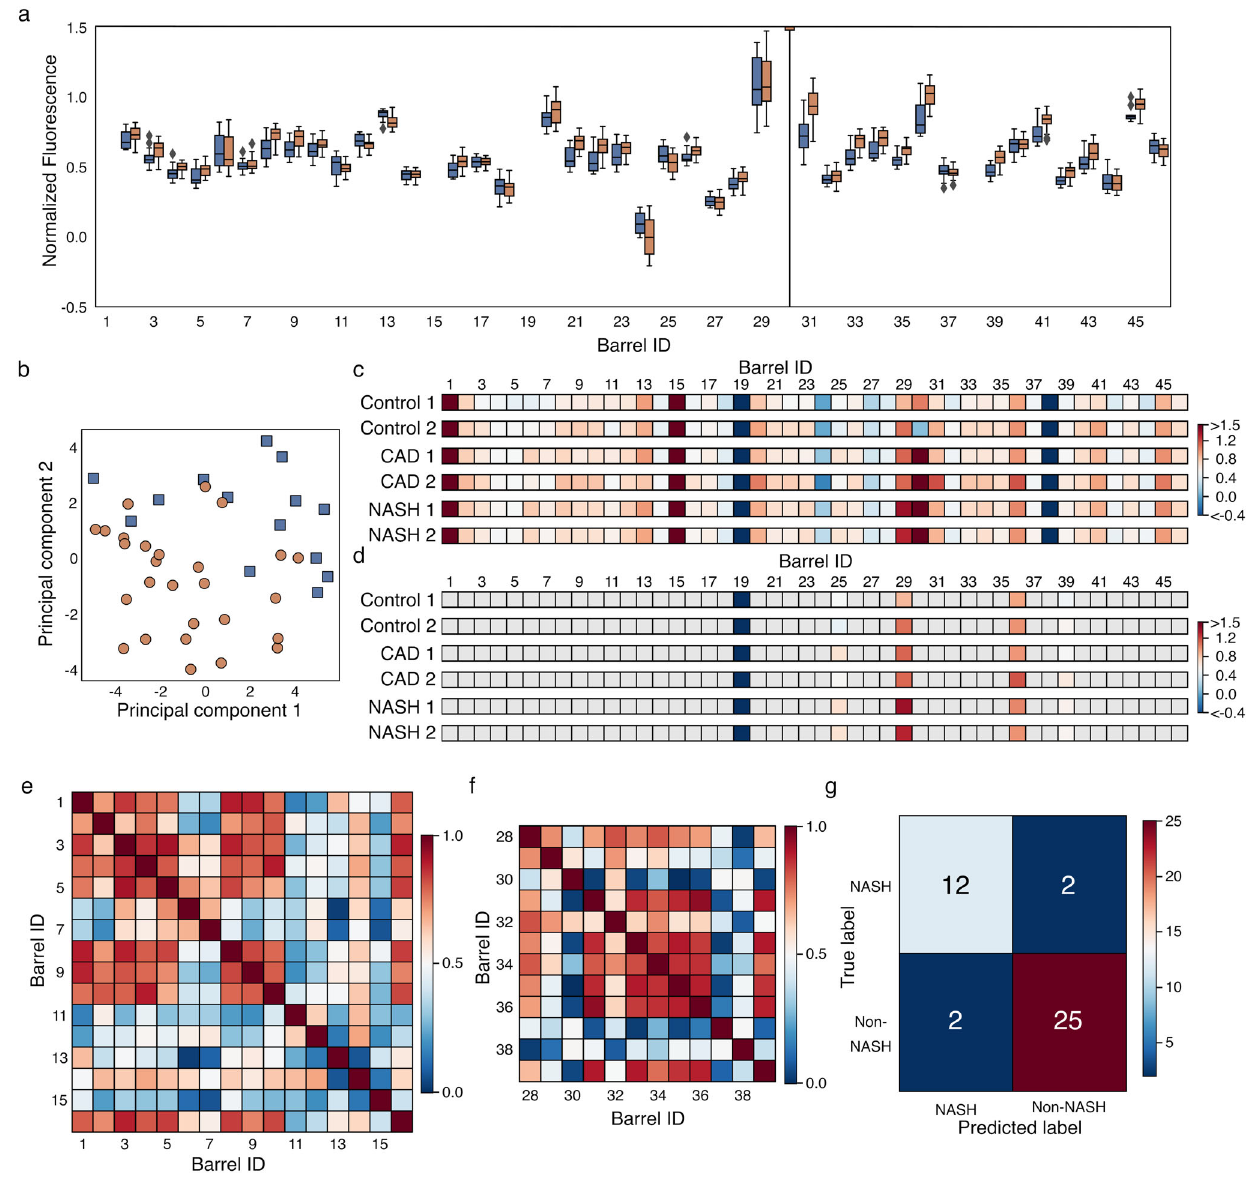
Fig. 4 | Challenging the α SA with diagnostically relevant samples. a Min – max scaled fl uorescent signals from the α SAs challenged with different NASH sera samples: NASH, blue; Non-NASH, orange. Values are normalized relative to: 1, for α HB and the reporter dye with no analyte; and 0, for dye alone. Values shown are between 1.5 and − 0.5 for clear visualization, full data range is shown in Supple- mentary Fig. 19. Data corresponds to 41 independent samples ( n =14 NASH, n =27 Non-NASH) that were each measured 4 times (technical repeats) to give a median measurementforeachsample.Boxesshowtheinterquartilerangewiththemedian presentedasaline.Whiskersshow1.5×interquartilerange,ortherangeifasmaller value. Outliers are shown as diamonds. b Principal component analysis of the 41 sera samples: NASH, blue squares; Non-NASH, orange circles. c Median dye- displacement data for select NASH sera samples. α HB ID is shown above each fi ngerprint. In these cases, min-max scaled dye displacement is colored from dark